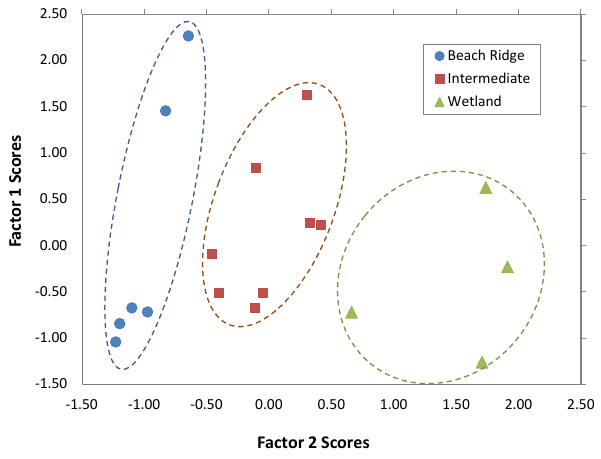
Figure 7. Scatter plot of the Factor 1 and 2 Scores from the varimax rotation showing three Fig. 7. Scatterplot of the factor 1 and 2 scores from the varimax clusters. rotation showing three